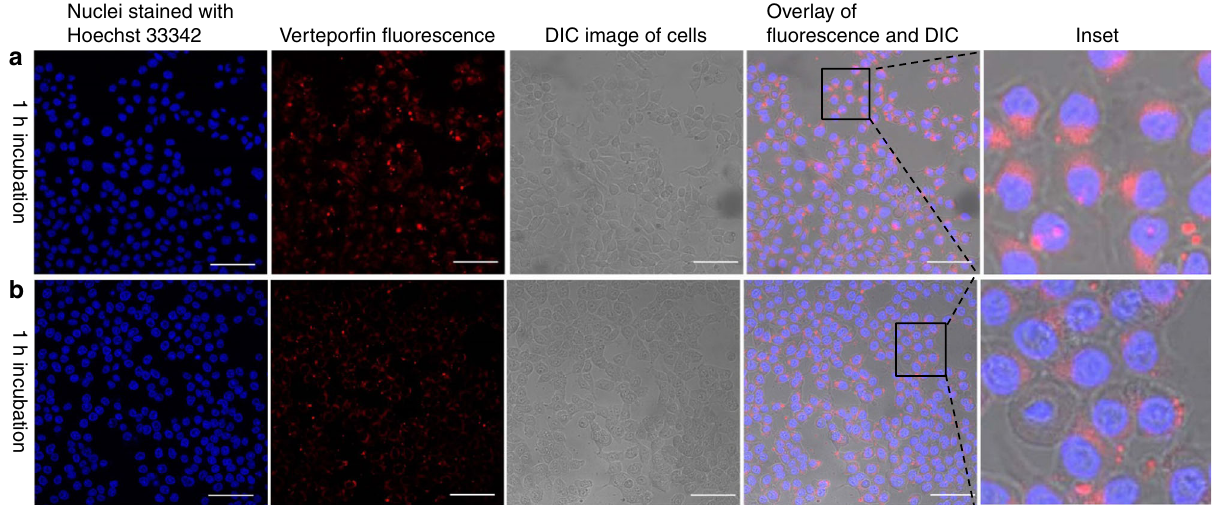
Fig. 4 Cellular uptake of folate-conjugated liposomes in HCT 116 cells and CCD 841 CoN cells. a , b Representative confocal laser scanning microscopy images of incubated ( a ) HCT 116 cells and ( b ) CCD 841 CoN cells with folate-conjugate liposomes (25 µ M) for 1 h. Scale bar is 75 µ